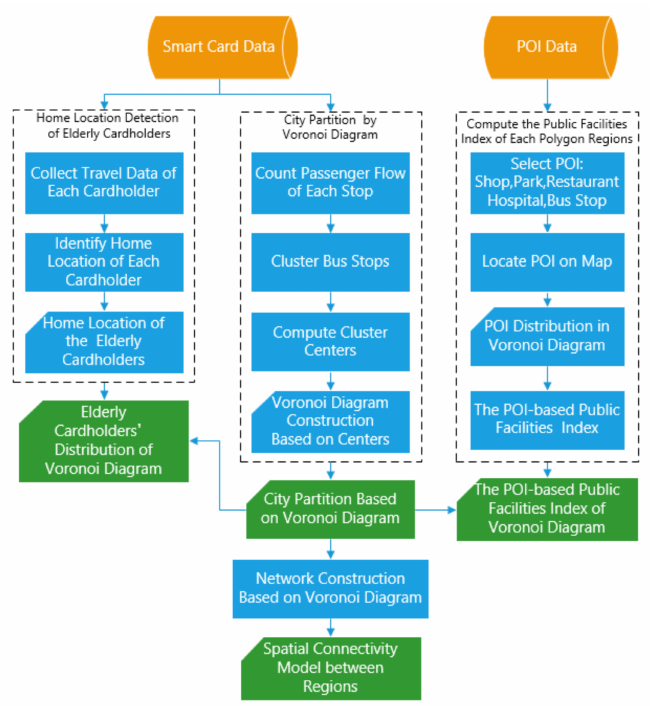
Figure 1. Analytics framework of the spatial distribution patterns of the elderly